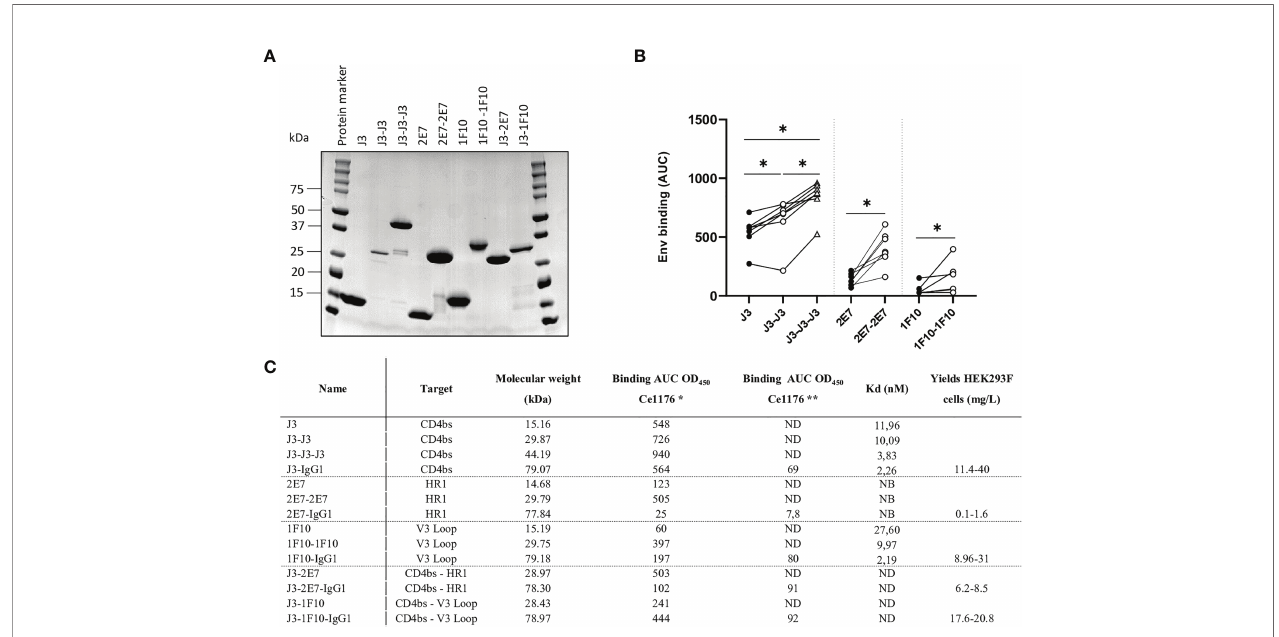
FIGURE 2 | Multivalent anti-HIV-1 nanobodies show increased binding towards HIV-1 Env trimers from global panel. (A) SDS-PAGE protein separation followed by coomassie blue staining of the puri fi ed anti-HIV-1 nanobody-constructs under reducing conditions. Molecular weight (MW) is indicated in kilodalton (kDa). (B) Average area under the curve (AUC) of binding curves of J3, 2E7 and 1F10 nanobody variants to SOSIP.v9.0 trimers from the global panel (CNE55, Ce1176_A3, 25710-2.43, CH119.10, BJOX002000.03.2, Ce7030 and 246-F3_C10) as determined by ELISA using OD 450 . Average AUC of OD450 was determined by doing a de fi nite integral between the start and end point using GraphPad. Friedman matched comparison (three groups) and Wilcoxon matched-pairs signed rank tests (two groups) was used to compare the groups with signi fi cance indicated as *p <0.05. Data shown are the average of three independent experiments. (C) Binding of nanobodies and nanobody-IgG1 constructs to Ce1176 as determined by ELISA. *The binding of the nanobody and nanobody-IgG1 constructs to the concerned epitopes was determined using an anti-VHH-HRP secondary antibody, starting concentration 500 nM.** The binding of the nanobody-IgG1 constructs to the concerned epitopes was determined using a Goat-anti-Human-HRP secondary antibody, starting concentration 50 nM. Kd values for BG505 SOSIP.664 as determined by BLI, based on the average association of different antibody concentrations. ND, not determined; NB, non-binding. Data are representative of at least two independent